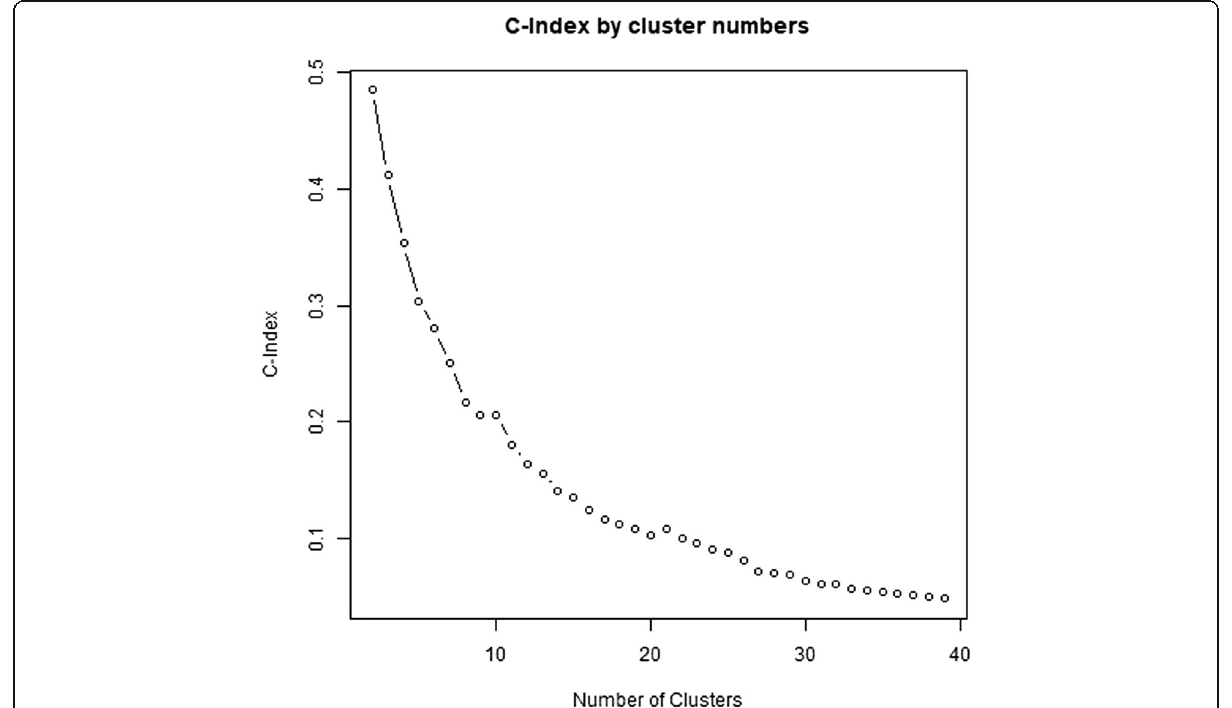
Fig. 3 C-Index plot of initial cluster analysis